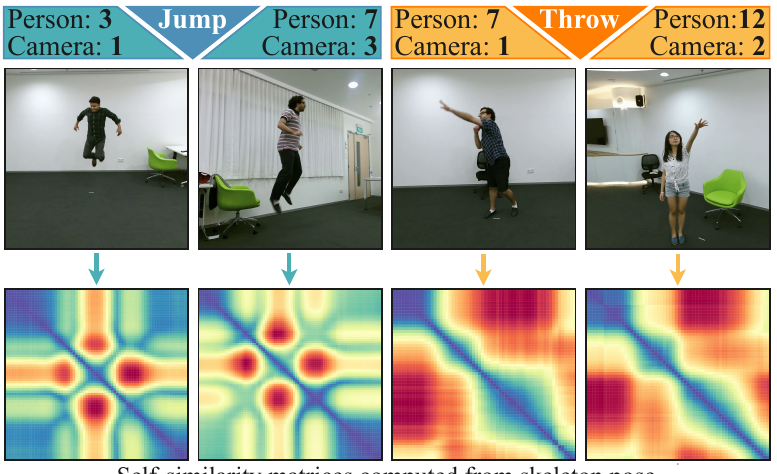
Figure 6. The first-row illustrates two actions performed by different subjects and under different poses (jump up in the first two columns and throw in the two rightmost columns). The bottom row provides the corresponding SSM yielding from the corresponding skeleton sequences (adapted from the work in [68]).